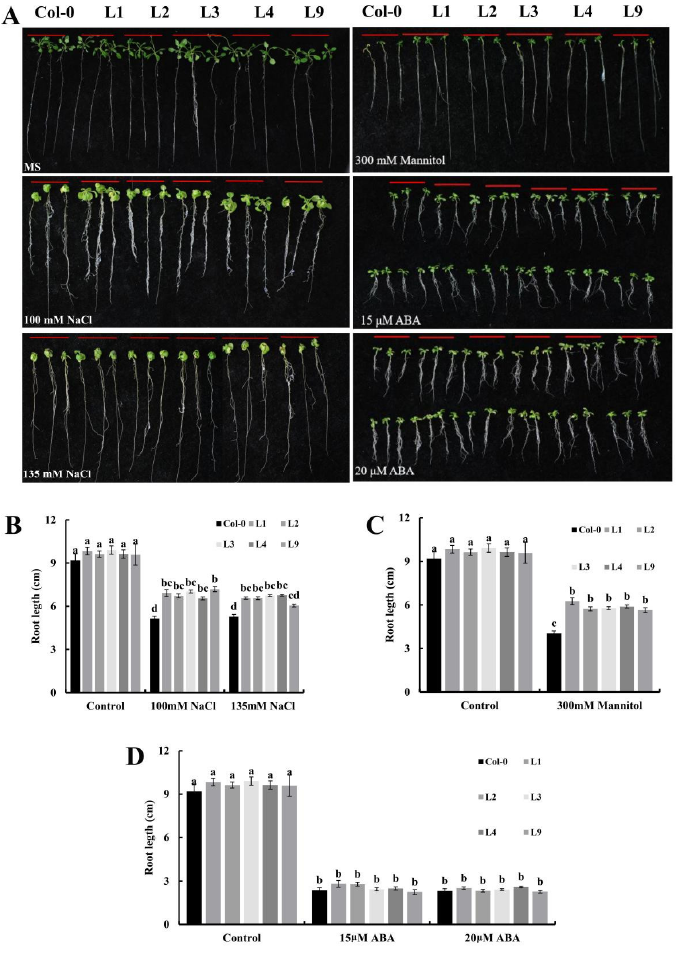
Figure 4. Roles of the GhGT26 gene in the primary root formation in Arabidopsis and transgenic plants. ( A ) Root growth of the transgenic plants and wild type (Col-0) under normal and 1/2 MS medium containing NaCl (100, 135 mM), mannitol (300 mM), and ABA (15, 20 μM). ( B ) The root length of transgenic plants and wild type (Col-0) under normal and on the 1/2 MS medium containing NaCl. ( C ) The root length on the 1/2 MS medium containing mannitol. ( D ) The root length on the 1/2 MS medium containing ABA. The different letters above the columns indicate significant differences ( p < 0.05) based the EM-based Student t test performed using GraphPad Prism 8.0. To investigate the potential molecular pathway affected by GhGT26 in regulating stress tolerance, two-week-old Col-0 and transgenic lines seedings were exposed to salt